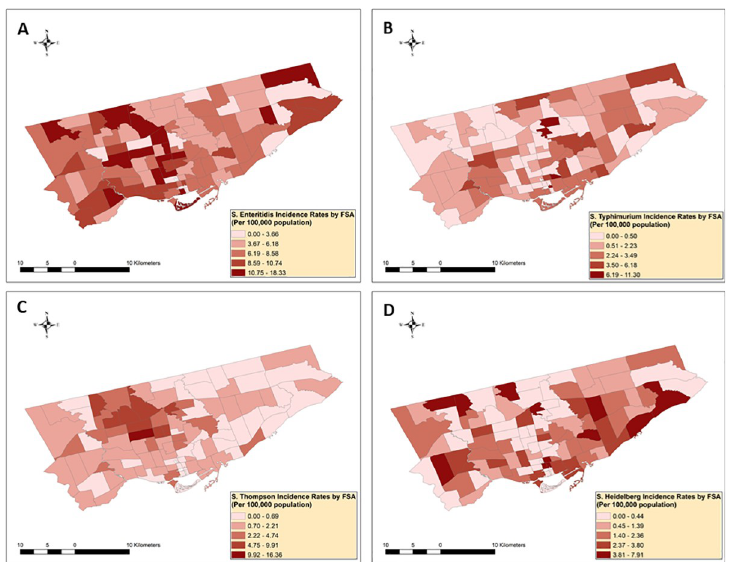
Fig 2. Distribution of non-smoothed nontyphoidal Salmonella enterica infection rates with serotypes (A) Enteritidis (n = 620), (B) Typhimurium (n = 150), (C) Thompson (n = 138) and (D) Heidelberg (n = 136) in Toronto’s forward sortation areas (n = 95), 2015 − 207 1